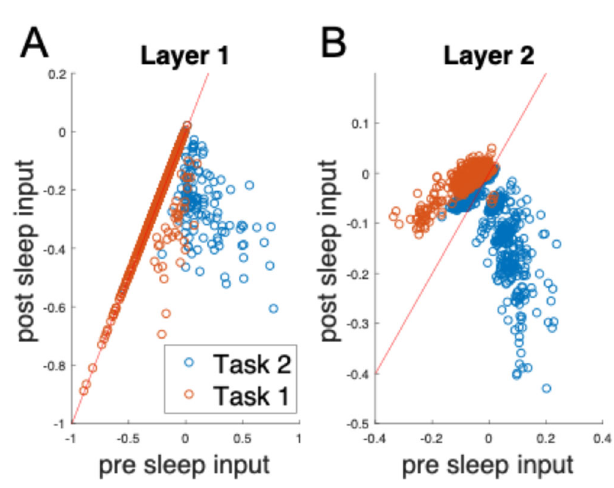
Fig. 5 | SRC changes input to the hidden layer neurons to favor old tasks. A In layer1(left),inputtotheneuronsrepresentingoldtaskisreducedlessthaninputto the neurons representing most recently learned task. B In layer 2 (right), SRC increases input to the neurons representing old task while decreasing input to the neurons representing most recently learned